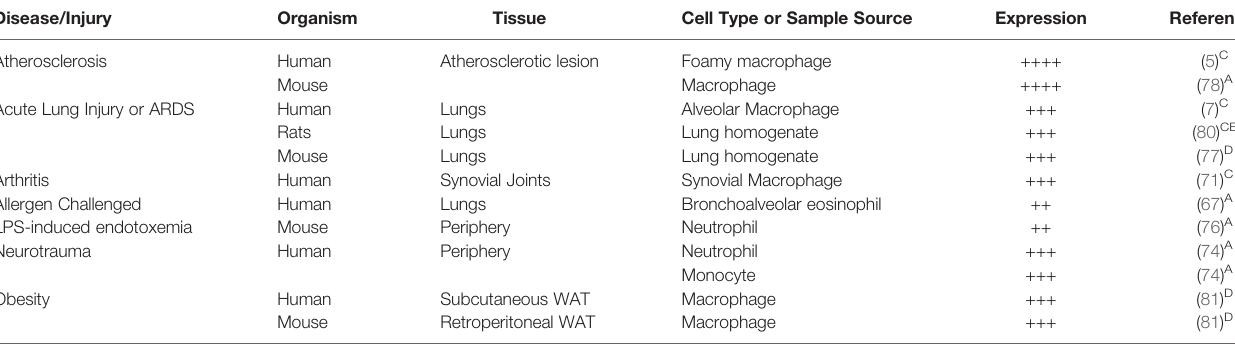
TABLE 2 | Upregulation of CD11d expression during various disease and injury states.